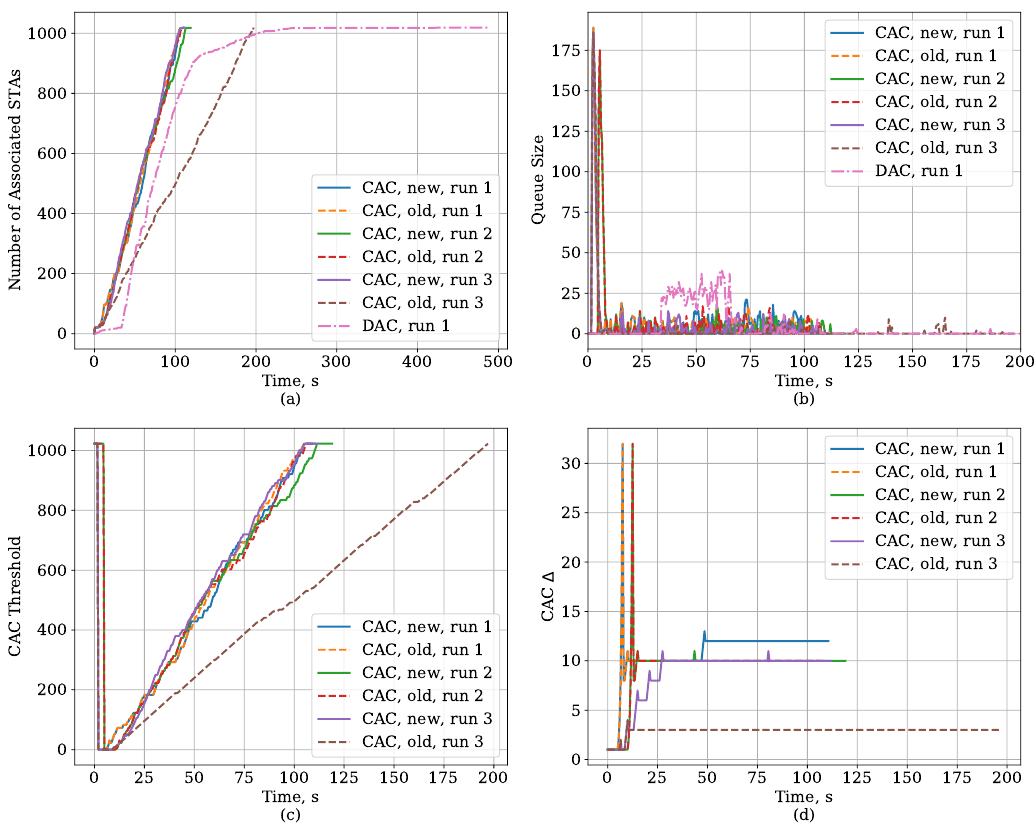
Figure 11. Time dependency of the CAC and DAC protocol parameters for the Large Area case with Capture Effect: ( a ) the number of associated STAs, ( b ) AP queue size, ( c ) CAC threshold, ( d ) the value of ∆ in